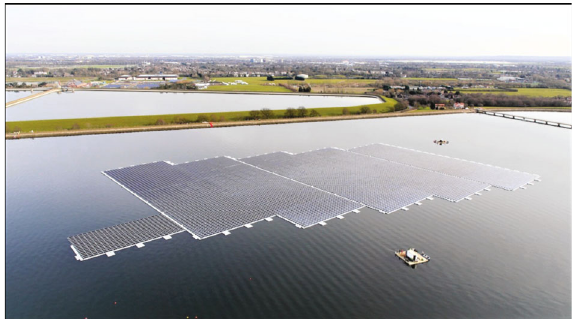
Figure 14: 6.3 MW fl oating solar farm in London ’ s Queen Elizabeth II reservoir [62].